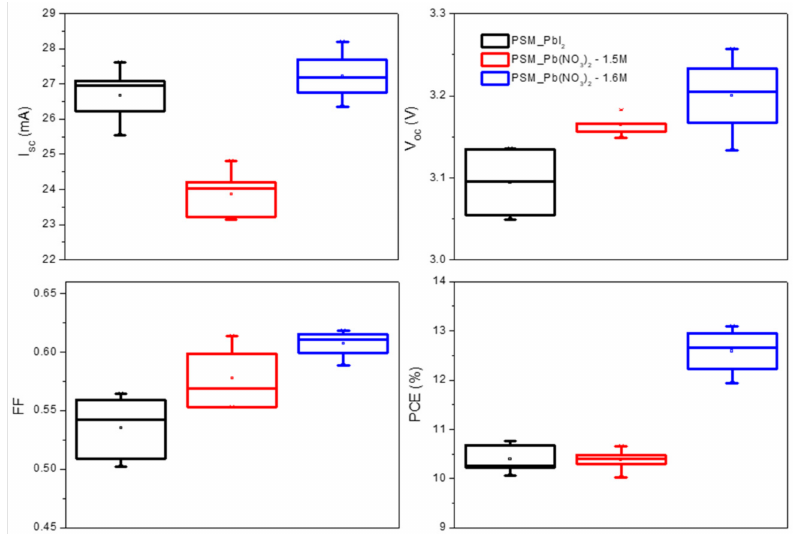
Figure 5. The box plot of IV measurement of PSM_PbI 2 , 1.5 M and 1.6 M PSM_Pb(NO 3 ) 2 two step dipping procedure.